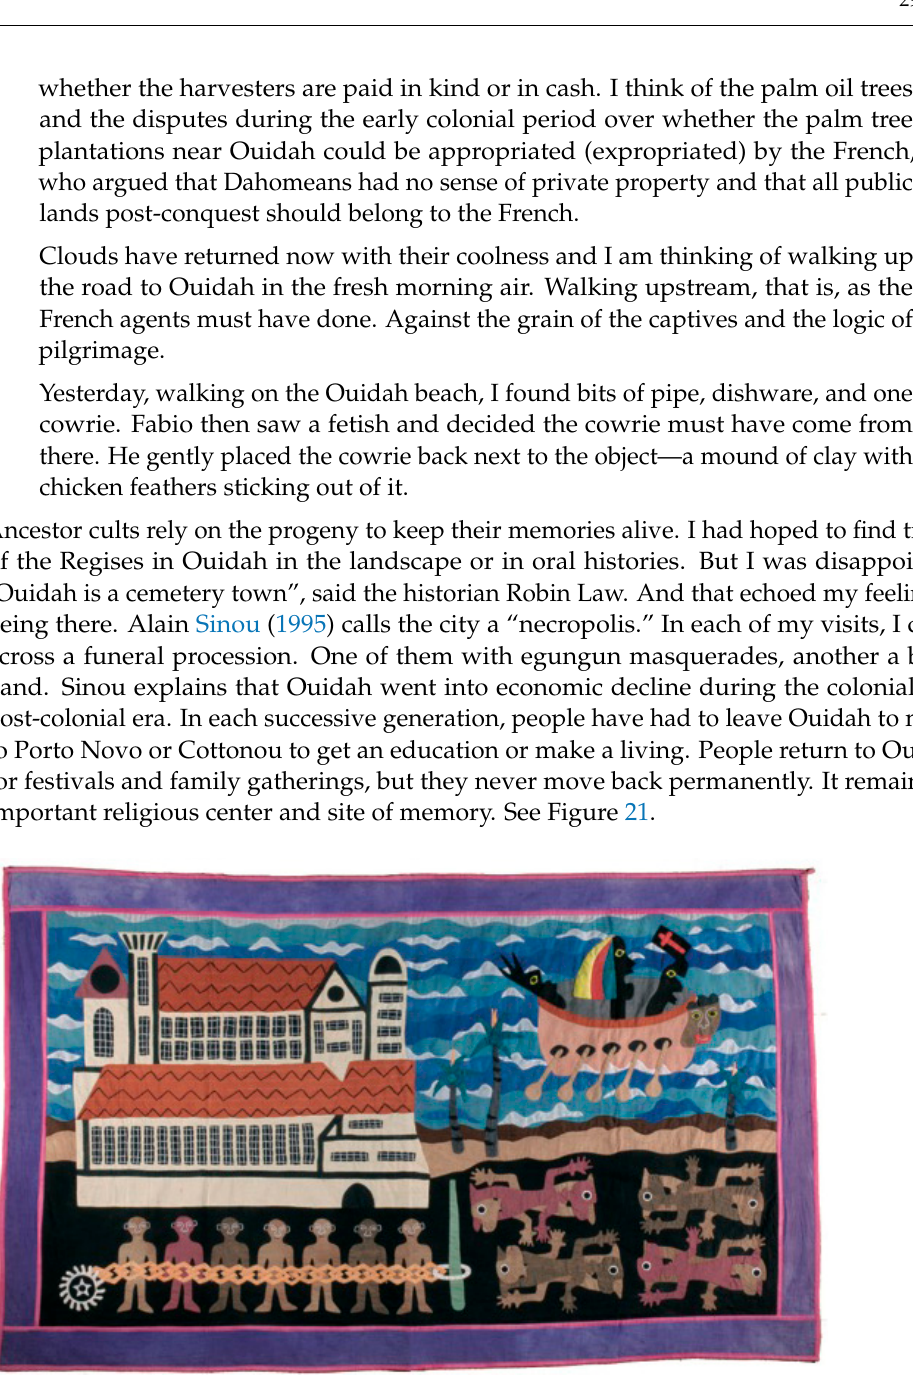
Figure 21. The Middle Passage N°7/18 from the “Black Ocean” series by William Adjété Wilson, 2009. Cloth appliqued 67” × 39”. Wilson, a French artist based in Paris, who is of Beninese and Togolese origin, worked with artisans in Abomey, Benin on a series of eighteen fabric panels that “bear witness to the richness of African culture” as well as “the infamous triangular trade.” (Recker 2009; Wilson 2009, see http://www.williamwilson.fr/en/black-ocean.fr (accessed on 18 August 2020)).